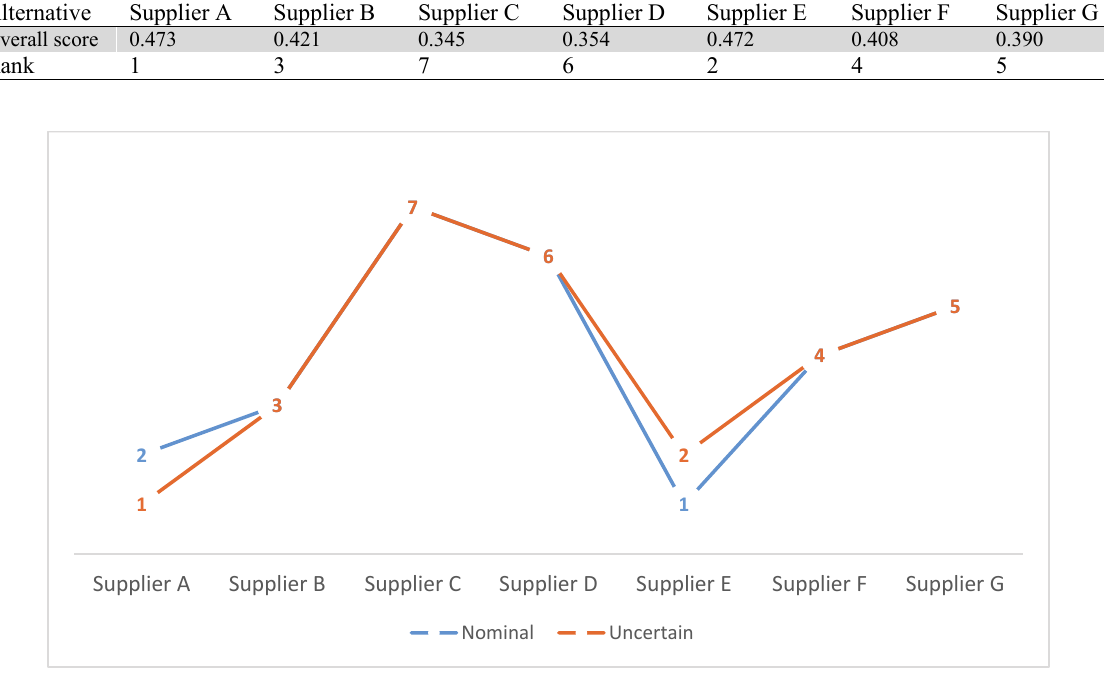
Fig. 3. The rankings of the alternatives in the nominal and uncertain problem of part 1